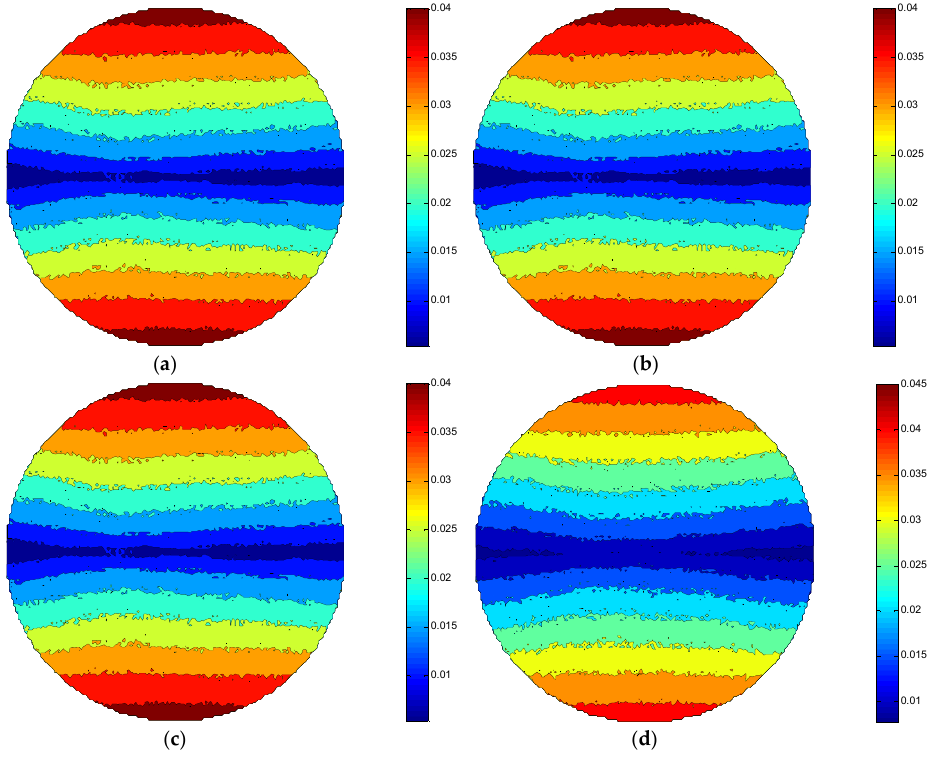
Figure 6. Distribution of MRR under different eccentric wheel rotational speed conditions: ( a ) n 0 = 10 rpm, ( b ) n 0 = 20 rpm, ( c ) n 0 = 30 rpm, ( d ) n 0 = 45 rpm.